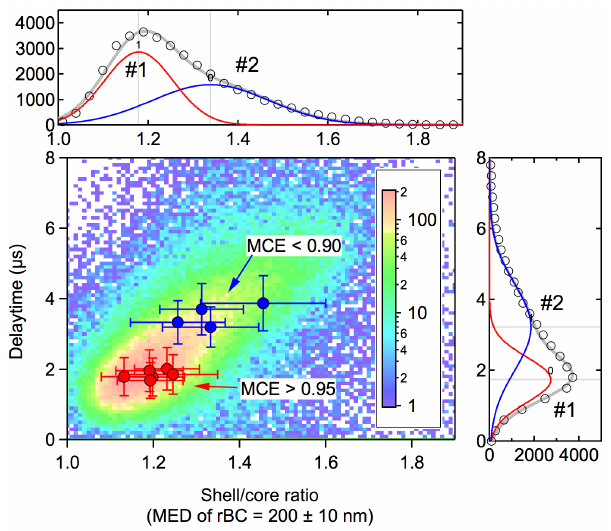
Figure 4. The dependence of the delay time of the peak of incan- descence signal after that of the scattering signal as a function of the shell/core ratio for the rBC particles with MED = 200 ± 10nm for all the burning cases, and the multiple Gaussian fitting for all the data of cross sections along the x -axis and y -axis. For comparison with the curve fitting results, observational data of the flaming-dominant (MCE>0.95, red circle) and smoldering- dominant (MCE<0.9, blue circle) cases are also shown in the fig-